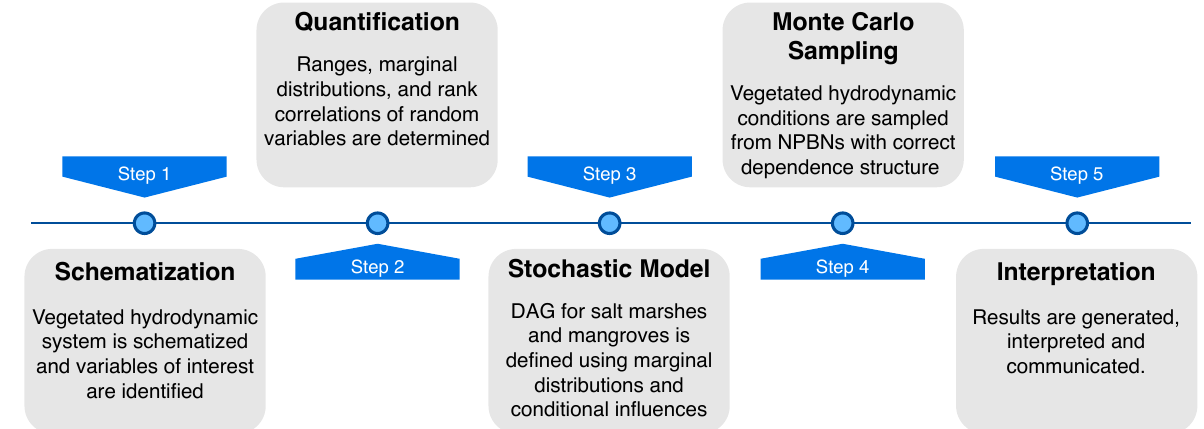
Figure 2. Overall methodology and steps for stochastic modeling in UNINET.